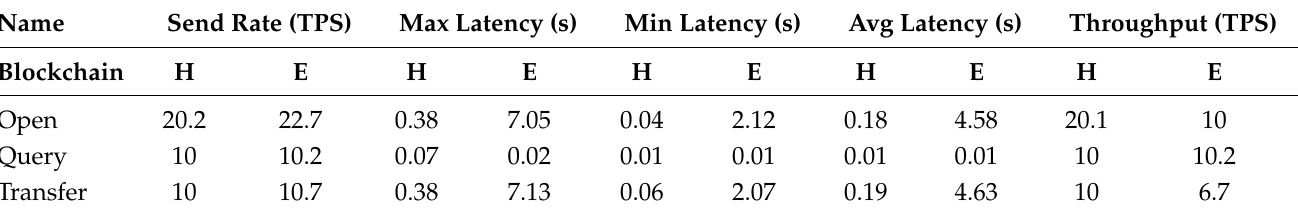
Table 3. Hyperledger and Ethereum performance metric summary (H: Hyperledger Fabric, E: Ethereum). Name Send Rate